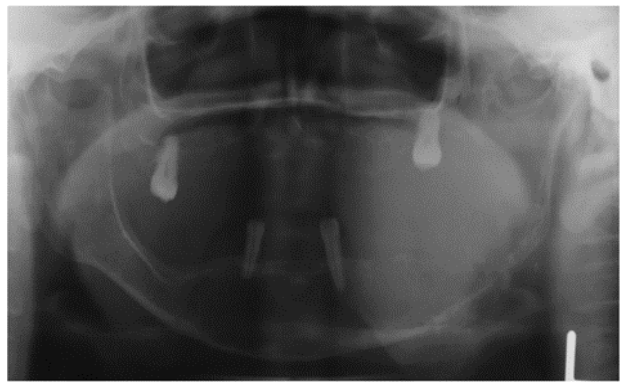
Fig. 3. The conventional radiograph showed a radiopaque image that occupied the body and ascending branch of the jaw.